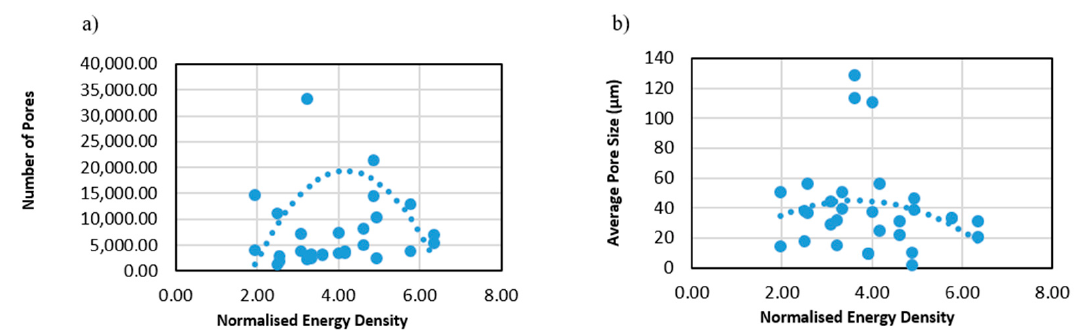
Figure 13. Melt track AR in relation to ( a ) beam speed and ( b ) beam power. Number of pores in relation to ( c ) beam speed and ( d ) beam power and average pore size in relation to ( e ) beam speed and ( f ) beam power.